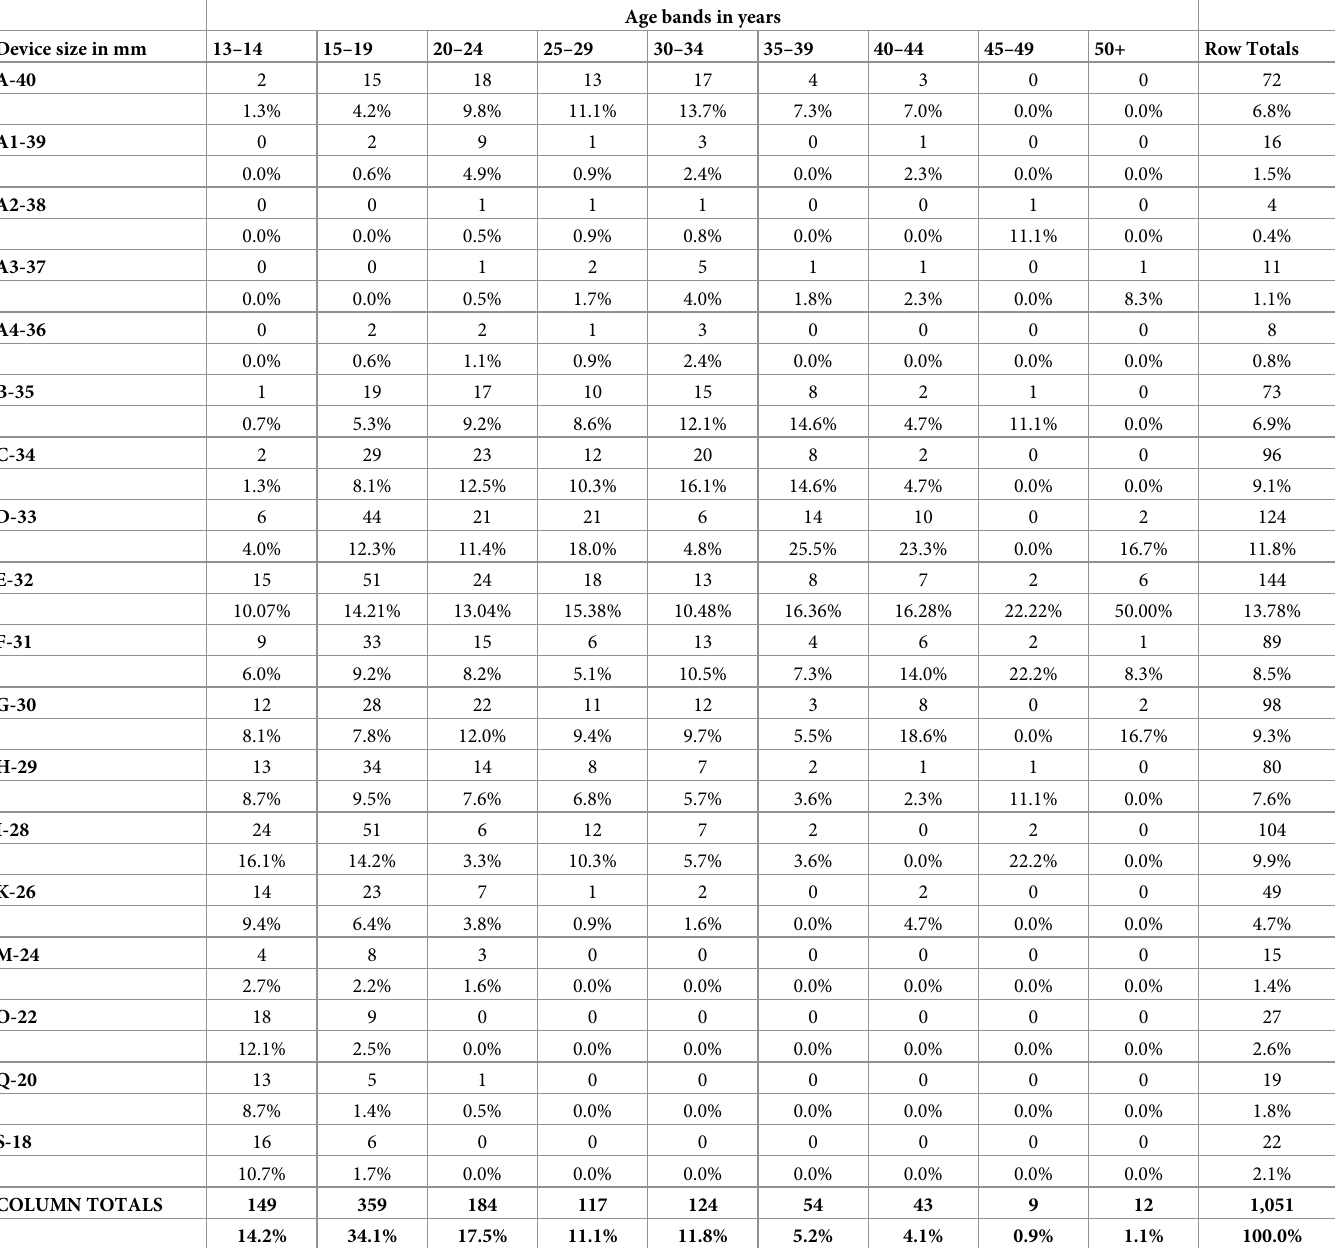
Table 3. ShangRing device sizes used among Kenyan males 13-64yrs (n =